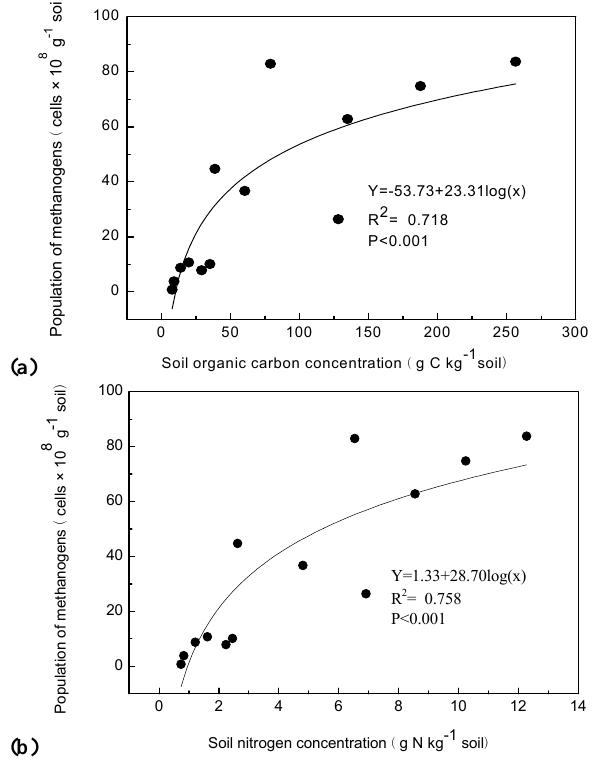
682 Fig. 5. Relationships between population of methanogenic archaea and soil organic carbon (a) or total nitrogen (b) concentrations in different soil layers of studied nautral wetlands across China.